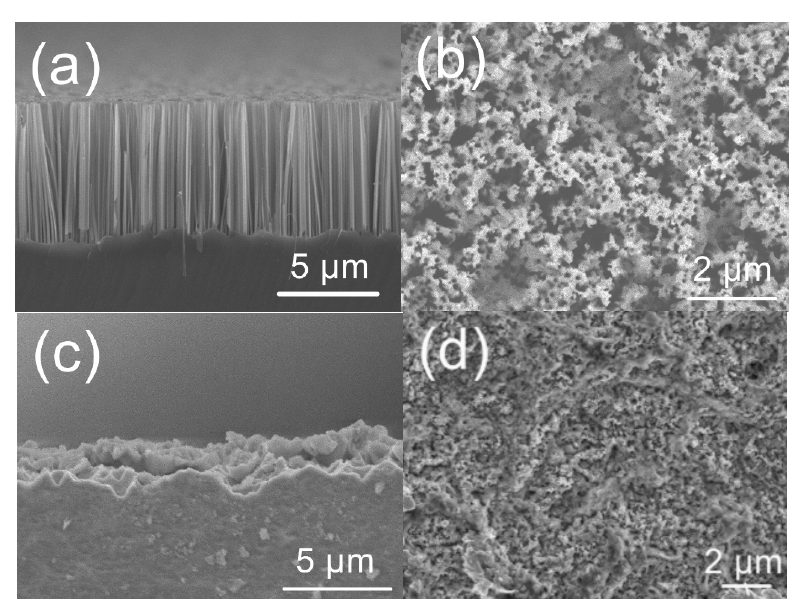
Figure 1. ( a , c ) Cross-sectional and ( b , d ) top SEM images of silicon morphology following metal- assisted chemical etching (MACE) procedure. ( a , b ) Silicon nanowire array etched with 4.8 M HF and 0.1